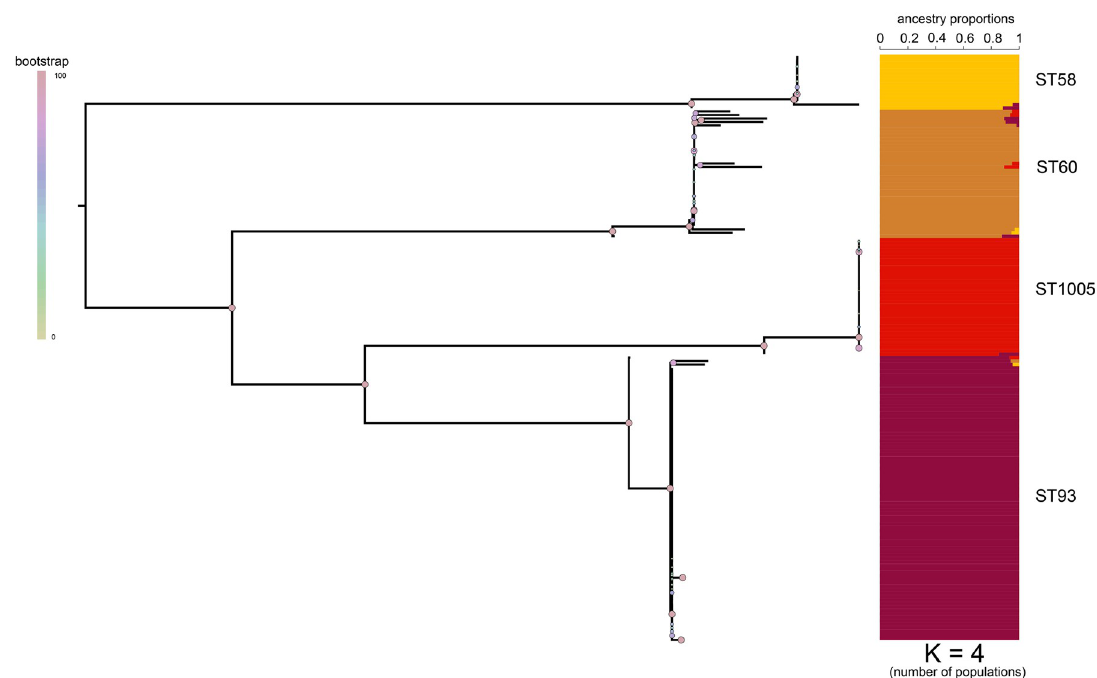
Fig 3. The population structure of INT2 genomes, as revealed by fastSTRUCTURE [53]. The maximum likelihood tree was inferred with IQ-TREE [48] on 22,080 concatenated SNPs using the TVM+F+ASC+R2 substitution model [49]. Four clear populations are present, corresponding to ST58, ST60, ST1005, and ST93, with limited admixing between STs. Each color represents a population and each individual genome is displayed as a horizontal line subdivided into color blocks whose lengths represent the admixture proportions from K = 4 populations.